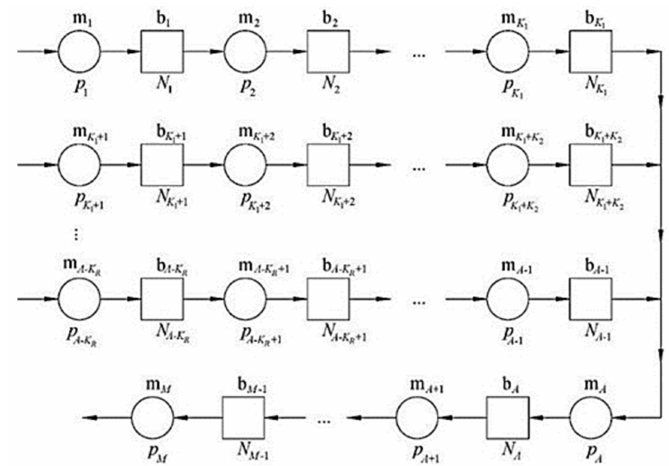
Figure 2. A model of a Bernoulli assembly